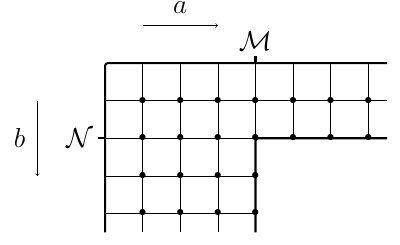
Figure 1: The fat hook domain H (cid:77)|(cid:78) of admissible Young diagrams for the super- algebra gl (cid:77)|(cid:78) . Bullet points correspond to admissible coordinates ( a , b ) defining rectangular Young